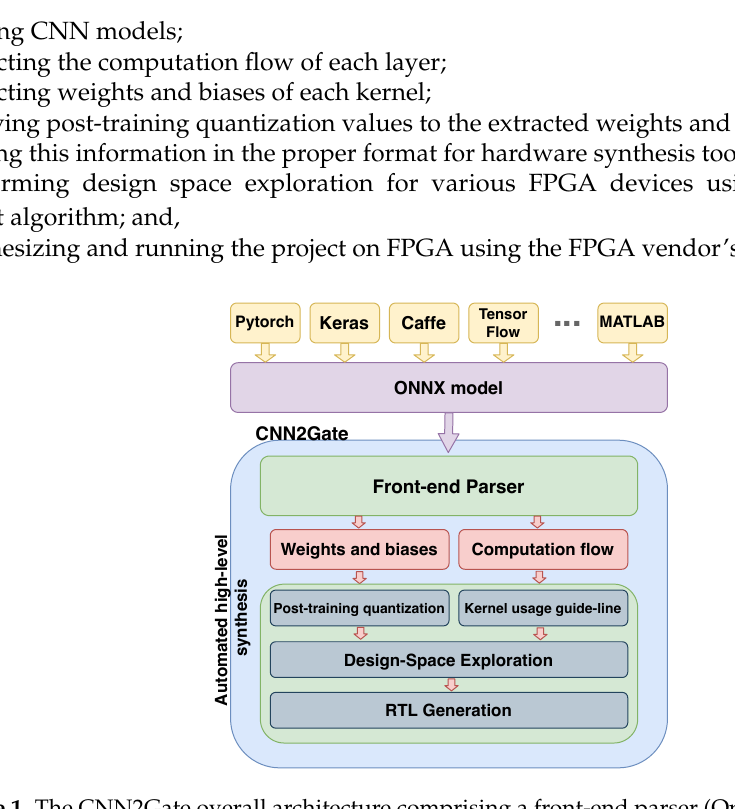
Figure 1. The CNN2Gate overall architecture comprising a front-end parser (Open Neural Network eXchange format (ONNX) parser), a design-space exploration module, and leverages automated high-level